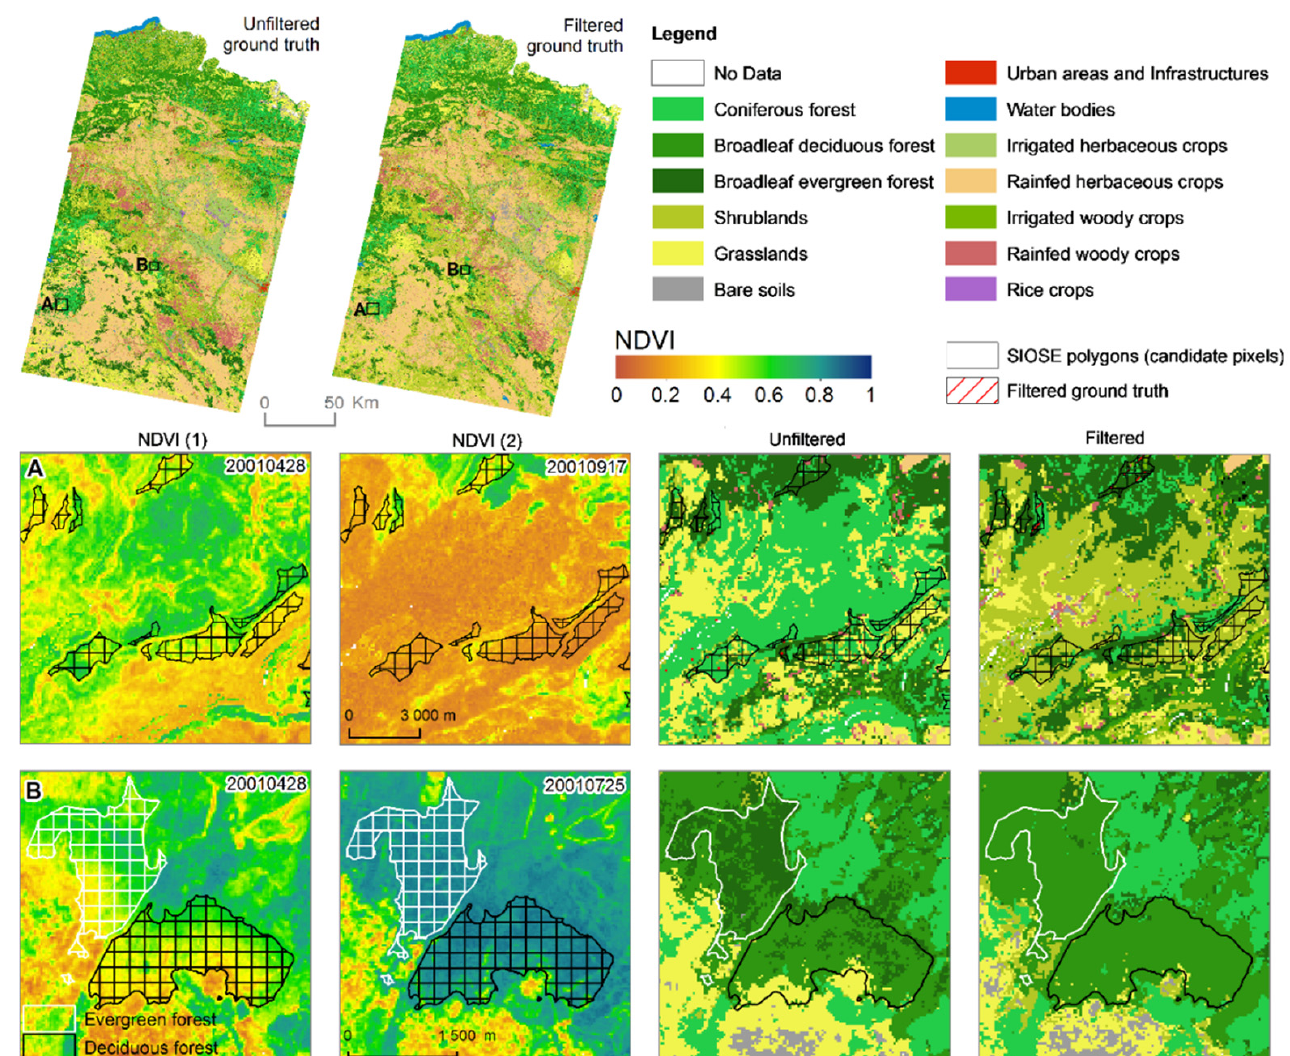
Figure 16. Examples of applying the filtering rules. In ( A ), coniferous polygons affected by clear-cutting forestry practices are shown (outlined in black). An intra-annual NDVI drop is produced. Unfiltered TTA misclassified the area as coniferous forest, while filtered TTA classified the area correctly as shrublands and grasslands. In ( B ), a mislabelled broadleaf evergreen forest (in white) polygon and a correctly labelled broadleaf